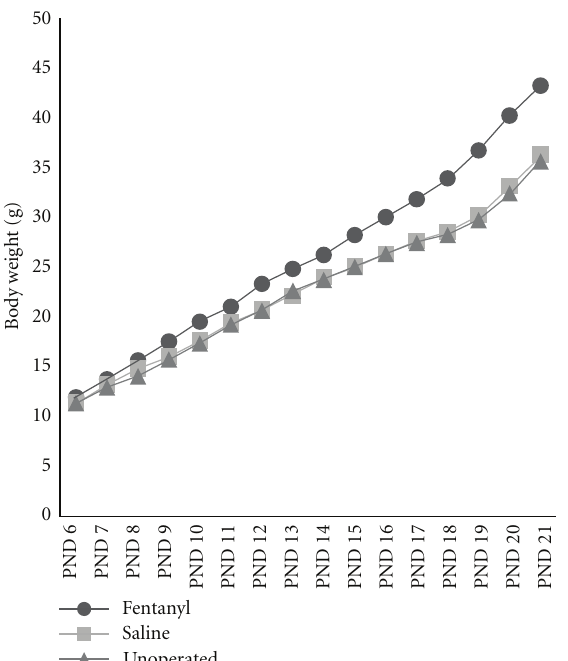
Figure 2: Growth curves representing mean body weight (g) through postnatal days (PNDs) 6–21. Fentanyl group showed enhanced weight gain compared to controls, after PND 12.